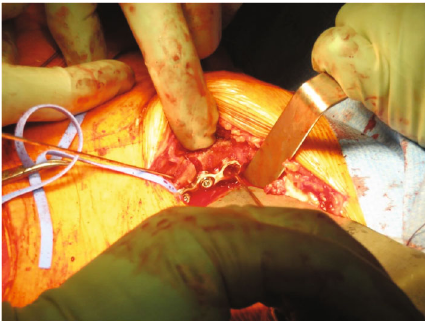
Figure 9: Intraoperative picture showing the plate fi xation of the recycled autograft at the level of the iliopubic ramus.